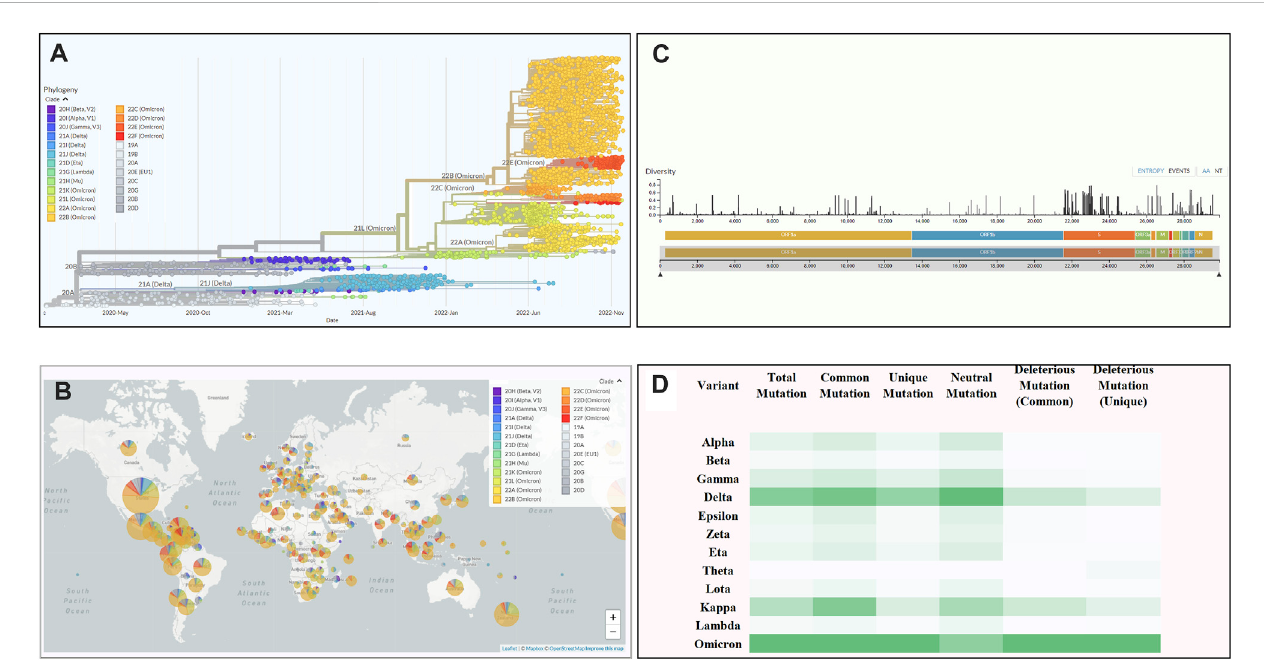
FIGURE 2 Anoverviewofthescenarioofcoronavirus. (A) PhylogenetictreeofSARS-CoV-2depictingvariantemergencefromJanuary2020toJanuary2022. (B) A world map depicting the frequency of variants occurring across the world. (C) The total number of mutations occurring across the whole genome of SARSCoV-2.Thelengthofthebardeterminesthediversityofmutationsataspeci fi cpositiononthegenome.(D)Thetotalnumberofmutationsalongspeci fi c types like common, unique, neutral, and deleterious across all the variants of SARS-CoV-2. (Analysed by Nextstrain: